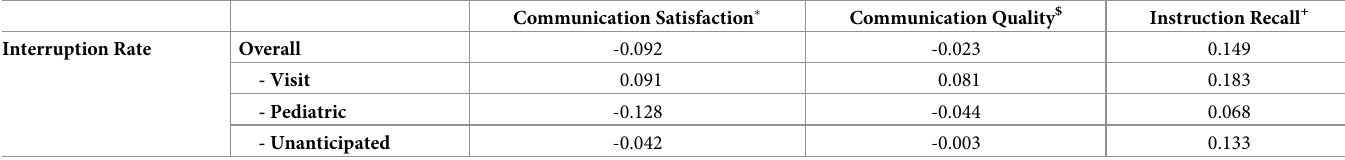
Table 4. Correlation between visit interruption rate and different outcome